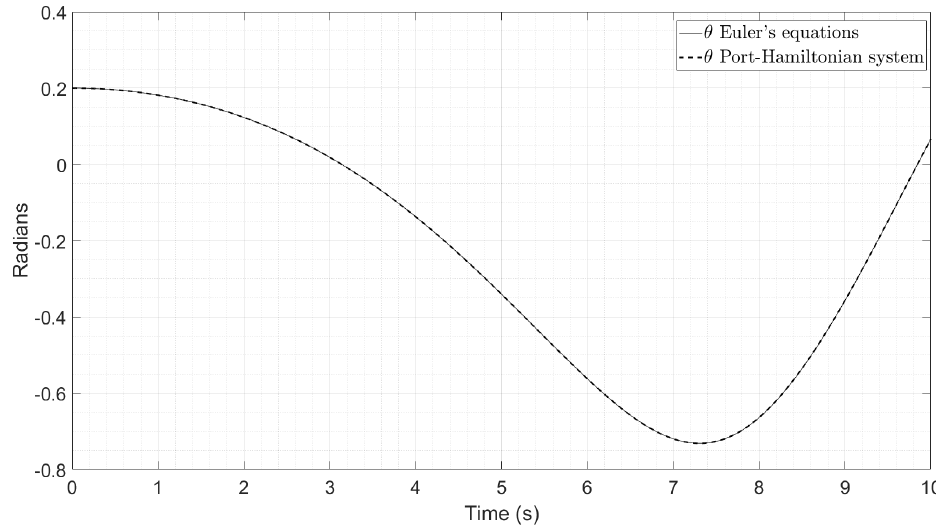
Figure 3. Comparison of the pitch angle ( θ ) between the Euler’s equations and the port- Hamiltonian system.